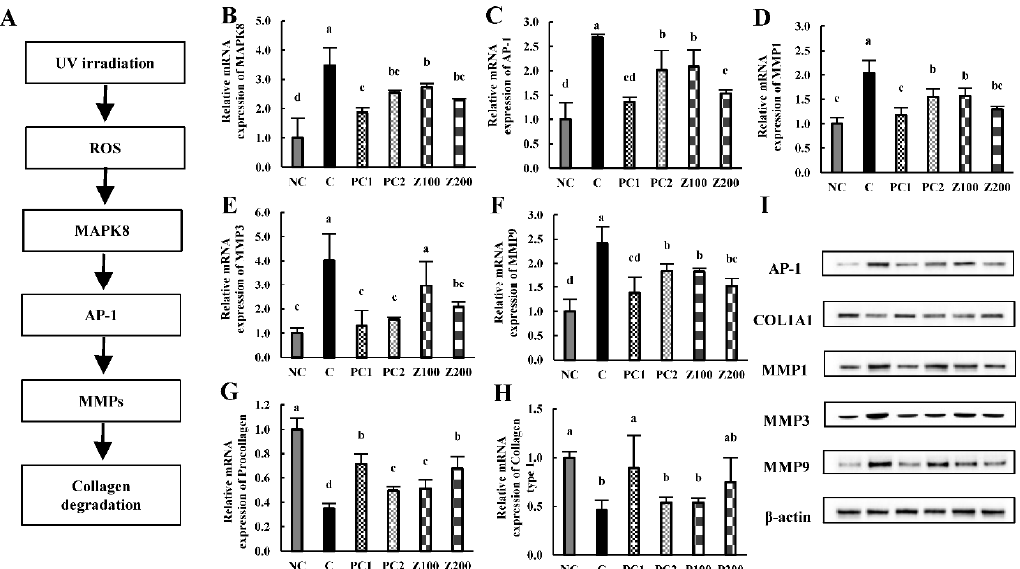
Figure 4. Inhibitory effects of FSH-ZM on mRNA and protein expression related to wrinkle formation in skin from the back of UVB-irradiated HRM-2 hairless mice. ( A ) The mechanism of wrinkle formation. ( B ) The expression of MAPK8 mRNA. ( C ) The expression of AP-1 mRNA. ( D ) The expression of MMP1 mRNA. ( E ) The expression of MMP3 mRNA. ( F ) The expression of MMP9 mRNA. ( G ) The expression of Procollagen mRNA. ( H ) The expression of Collagen type I mRNA. ( I ) Protein expressions. NC, normal control; C, UVB-irradiated control; PC1, positive control 1, L-ascorbic acid 200 mg/kg b.w.; PC2, positive control 2, Arbutin 200mg/kg b.w.; Z100, FSH-ZM 100 mg/kg b.w.; Z200, FSH-ZM 200 mg/kg b.w. Values are presented as mean ± standard deviation (n = 6), and different superscript letters indicate significance at p <